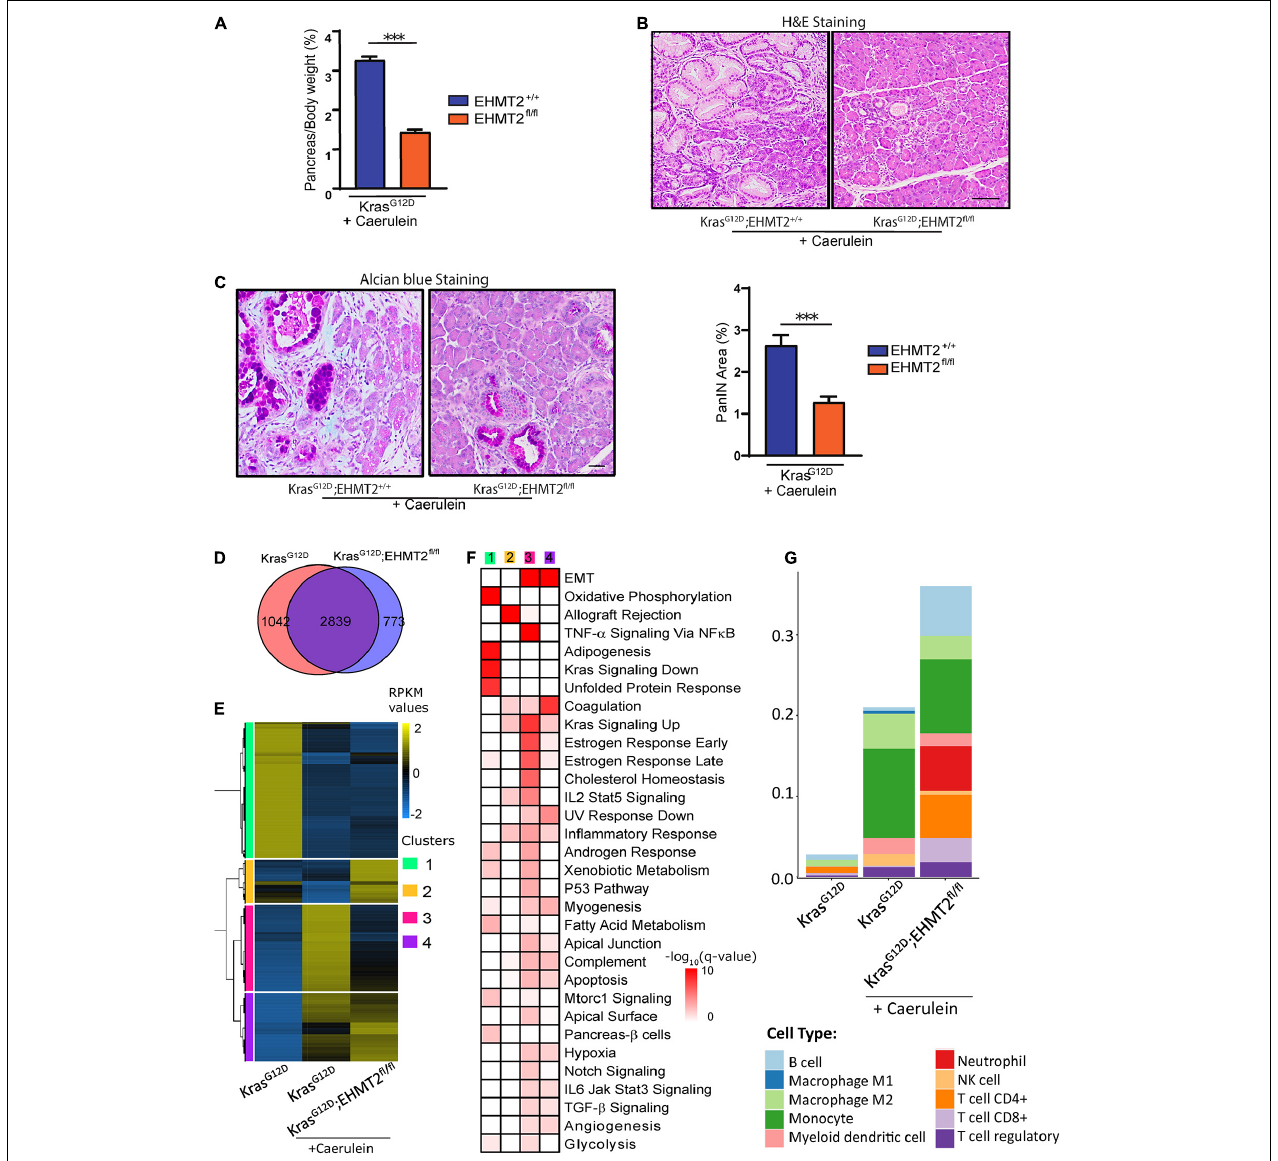
FIGURE 8 | Genetic inactivation of EHMT 2 in the inflammation-accelerated Kras G 12 D progression model diminishes effects on cell growth and gene expression. (A) 4-week-old Pdx1-Cre;LSL-Kras G 12 D ;EHMT2 + / + ( n = 5) and Pdx1-Cre;LSL-Kras G 12 D ;EHMT2 fl / fl ( n = 14) mice were treated with caerulein (50 µ g/kg/day) for 4 weeks to induce repeated chronic pancreatitis. Graph depicts reduced pancreas-to-body weight ratios after caerulein treatment in Pdx1-Cre;LSL-Kras G 12 D mice with EHMT2 inactivation. (B) Representative H&E images from pancreas tissue after 4 weeks of caerulein treatment in Pdx1-Cre;LSL-Kras G 12 D ;EHMT2 + / + (left) and Pdx1-Cre;LSL-Kras G 12 D ;EHMT2 fl / fl (right) animals. Image on the right demonstrates significantly fewer lesions in animals carrying EHMT2 inactivation. Scale = 50 µ M. (C) Representative Alcian blue images from pancreas tissue after 4 weeks of caerulein treatment in Pdx1-Cre;LSL-Kras G 12 D ;EHMT2 + / + and Pdx1-Cre;LSL-Kras G 12 D ;EHMT2 fl / fl animals (left). Scale = 50 µ M. Quantification of Alcian blue-positive PanIN lesions expressed as percentage (%) of pancreas area in Pdx1-Cre;LSL-Kras G 12 D ;EHMT2 + / + ( n = 5) and Pdx1-Cre;LSL-Kras G 12 D ;EHMT2 fl / fl ( n = 6) animals after caerulein treatment (right). (D) Venn diagram of DEGs in caerulein-treated Pdx1-Cre;LSL-Kras G 12 D ;EHMT2 + / + and Pdx1-Cre;LSL-Kras G 12 D ;EHMT2 fl / fl animals relative to age-matched, untreated Pdx1-Cre;LSL-Kras G 12 D ;EHMT2 + / + control animals ( n = 3/group). (E) Heatmap shows RPKM expression levels of DEGs normalized to the z-scale. Hierarchical clustering representing four major expression patterns is labeled on the left of the heatmap (green, Cluster 1; orange, Cluster 2; pink, Cluster 3; and purple, Cluster 4). Average of normalized RPKM values is represented in yellow (up), blue (down) and black (no change). (F) Pathway enrichment analysis of gene clusters in panel (E) . Color scale designates –log 10 ( q -value) for significance of each represented pathway. Gene networks of specific pathways are illustrated in Supplementary Figure 7B . (G) Immune cell type profiling demonstrates the percentage of infiltrating immune cell types obtained by quanTIseq analysis of DEG from caerulein-treated Pdx1-Cre;LSL-Kras G 12 D ;EHMT2 + / + and Pdx1-Cre;LSL-Kras G 12 D ;EHMT2 fl / fl mice. Scores representing the absolute fractions of immune cells show that while caerulein-treated Kras G 12 D animals had an enrichment in Tregs, NK cells, myeloid dendritic cells, monocytes and M2-type macrophages, caerulein-treated Kras G 12 D animals with inactivation of EHMT2 also had increased infiltration of CD8+ and non-regulatory CD4+ T cells, B cells and neutrophils. ∗∗∗ indicates p -value ≤ 0.001. All data is expressed as mean ± SEM.